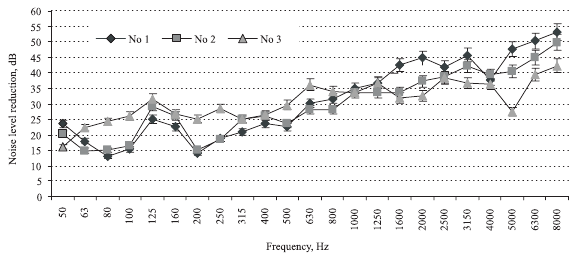
Fig. 2. Results of noise level reduction in the samples of experi- mental structures (No 1, No 2, No 3 – sample structures in Table 1)